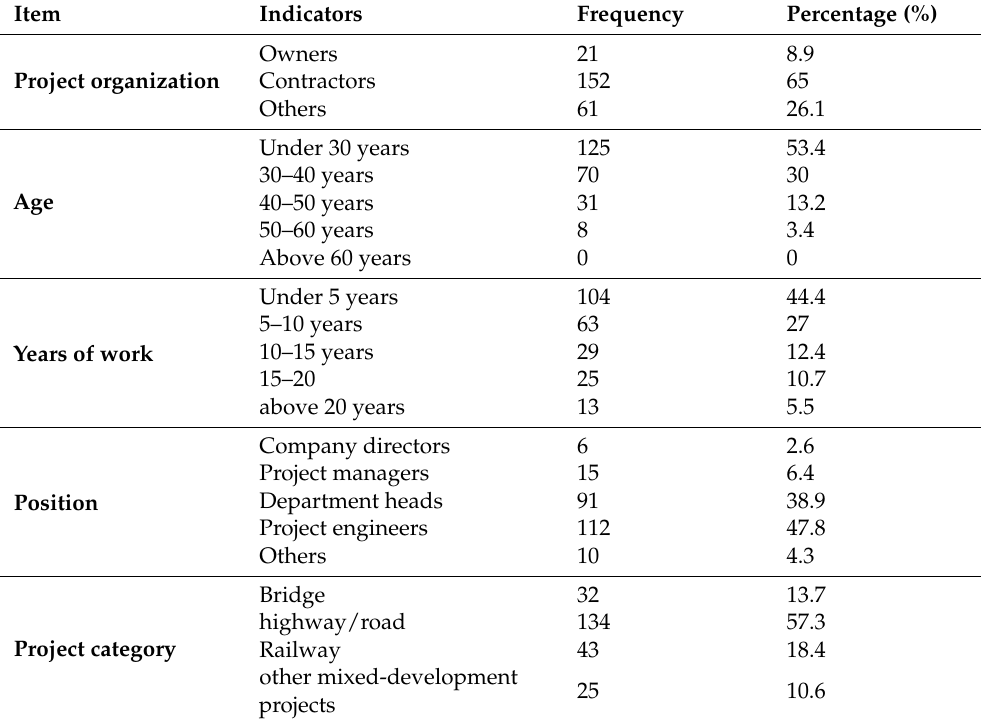
Table 1. Basic information on respondents and